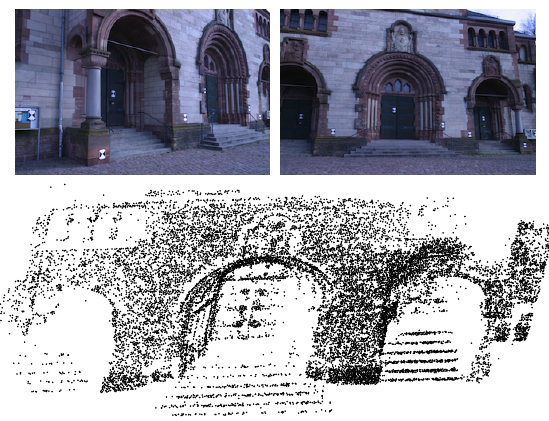
Figure 4: Top: two of 8 images of the Herz-Jesu-P8 sequence. Bottom: the sparse 3D reconstruction obtained with our